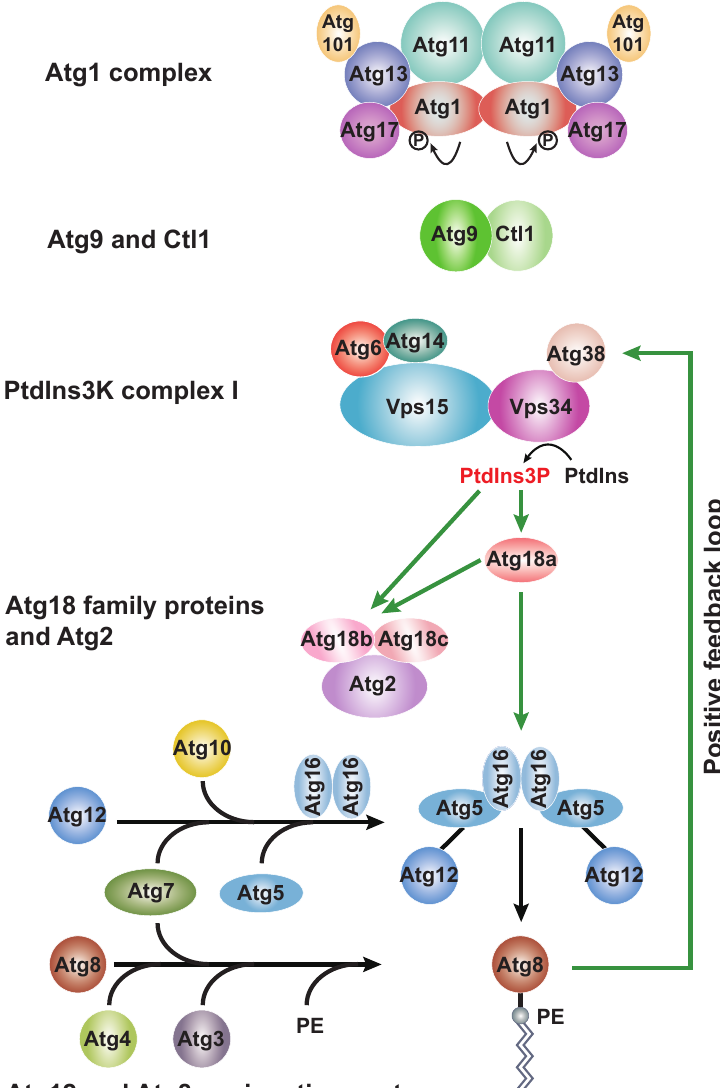
Figure 1. Six functional groups involved in autophagosome biogenesis in fission yeast. The Atg1 complex, Atg9 and Ctl1, and the PtdIns3K complex I are important for autophagy initiation and act upstream of other autophagy factors. The lipid kinase Vps34 catalyzes the conversion of phos- phatidylinositol (PtdIns) to phosphatidylinositol-3-phosphate (PtdIns3P) at the PAS. PtdIns3P ef- fectors Atg18a, Atg18b, and Atg18c are recruited to the PAS. Atg18a promotes the PAS targeting of Atg18b, Atg18c, and Atg2 (our unpublished results). Atg18a also recruits the Atg12-Atg5 · Atg16 complex to the PAS to promote the conjugation of Atg8 to phosphatidylethanolamine (PE). Atg8 interacts with Atg38 to establish a positive feedback loop between Atg8 and the PtdIns3K complex I. Green arrows denote PAS recruitment. Black arrows denote promotion of Atg12 or Atg8